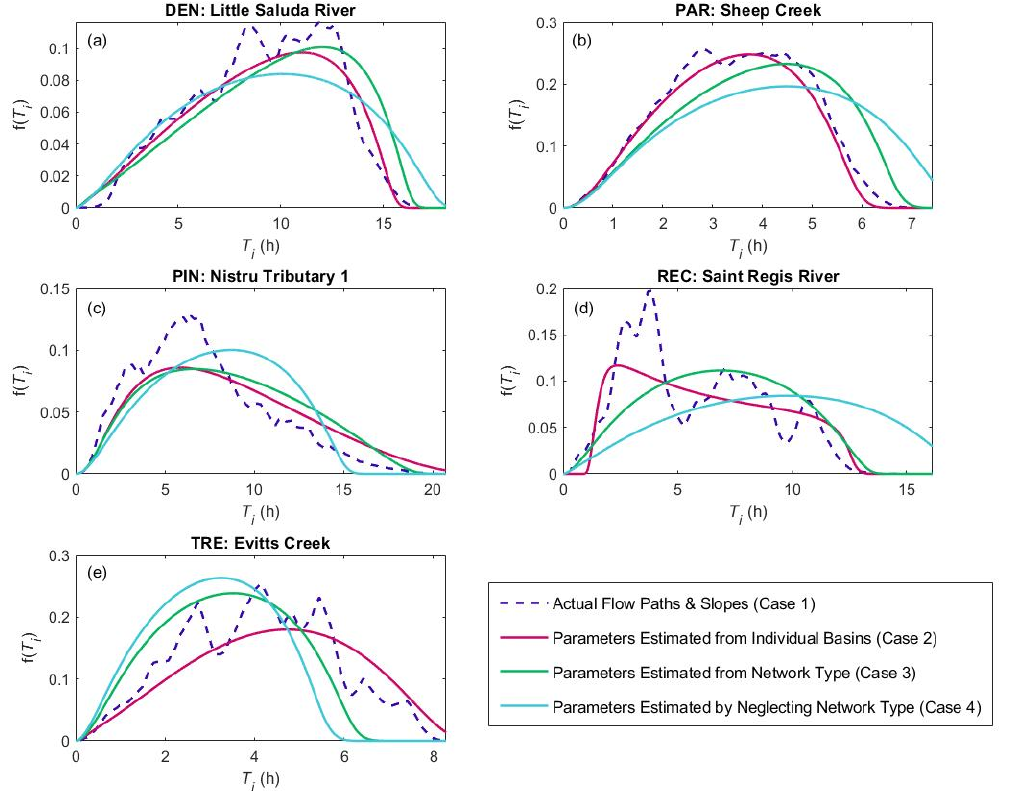
Figure 7. Instantaneous unit hydrographs (IUHs) estimated by the four methods described in the